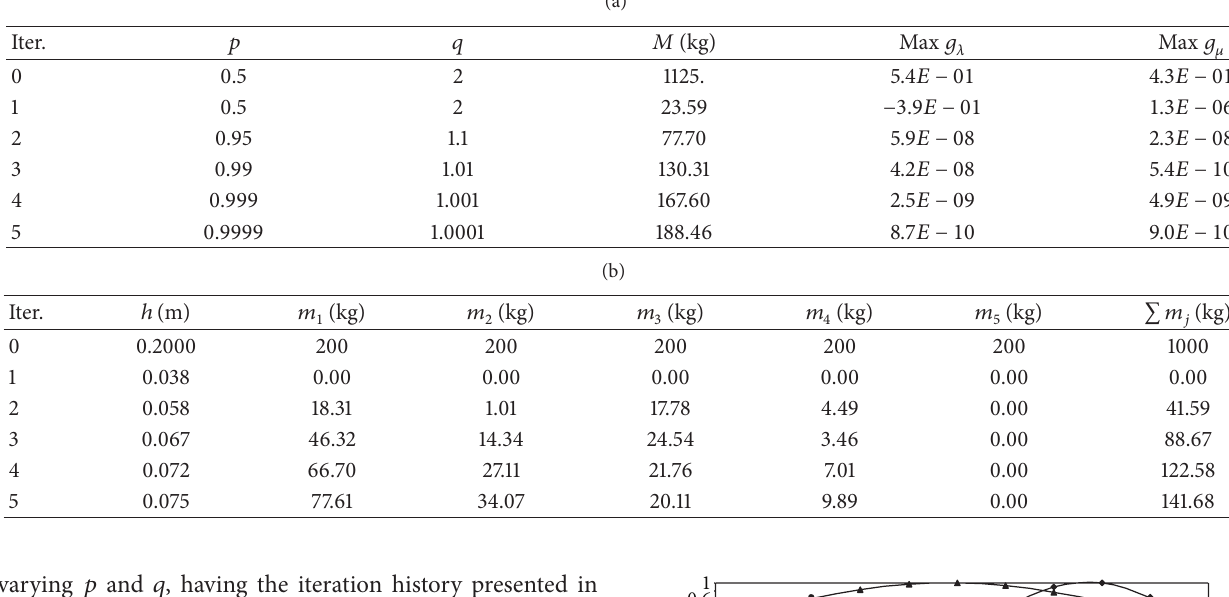
Table 6: Sequential optimization iteration history (Case 1).